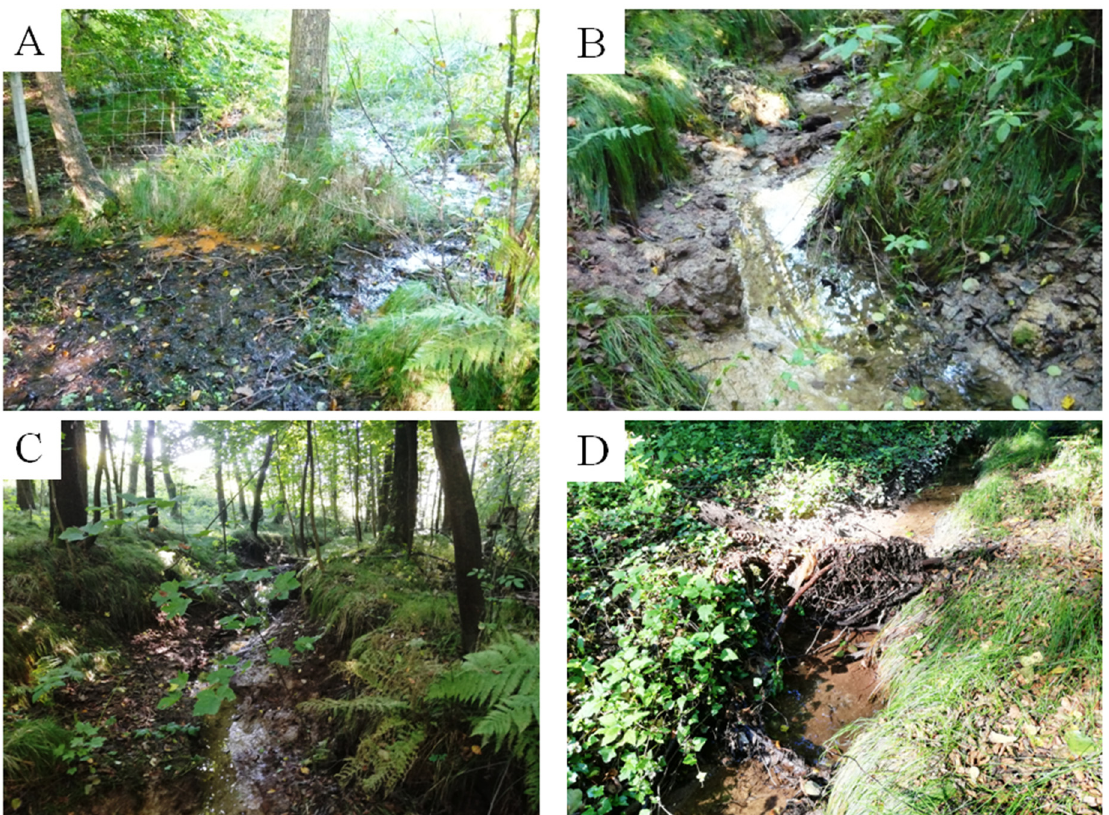
Figure 5. Selected elements of the hydromorphological diversity index in the semi-natural section: ( A )—marshy areas and spring zone; ( B )—laminar water flow; uniform vegetation on the slopes; ( C )—eroding bank undercuts; bank outwash not fixed with vegetation; ( D )—natural swelling by small wood bed load.